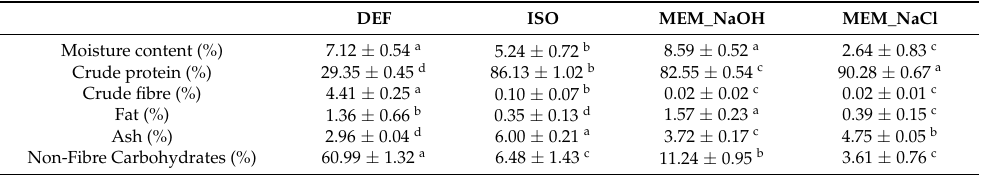
Table 1. Proximate composition of defatted lentil four (DEF), isoelectric pH-precipitated isolate (ISO), and membrane isolates from alkaline (MEM_NaOH) and salt (MEM_NaCl) solution extracts.